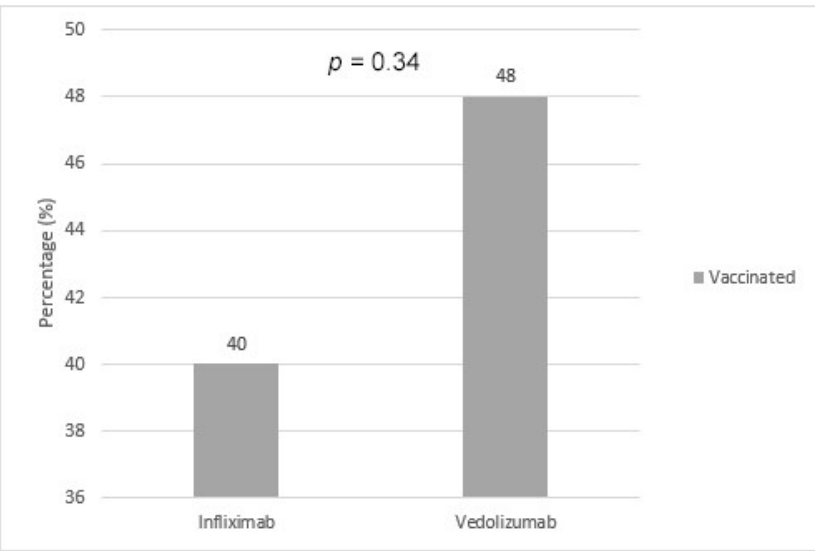
Figure 1. Demographics of patients with IBD based on vaccination status.